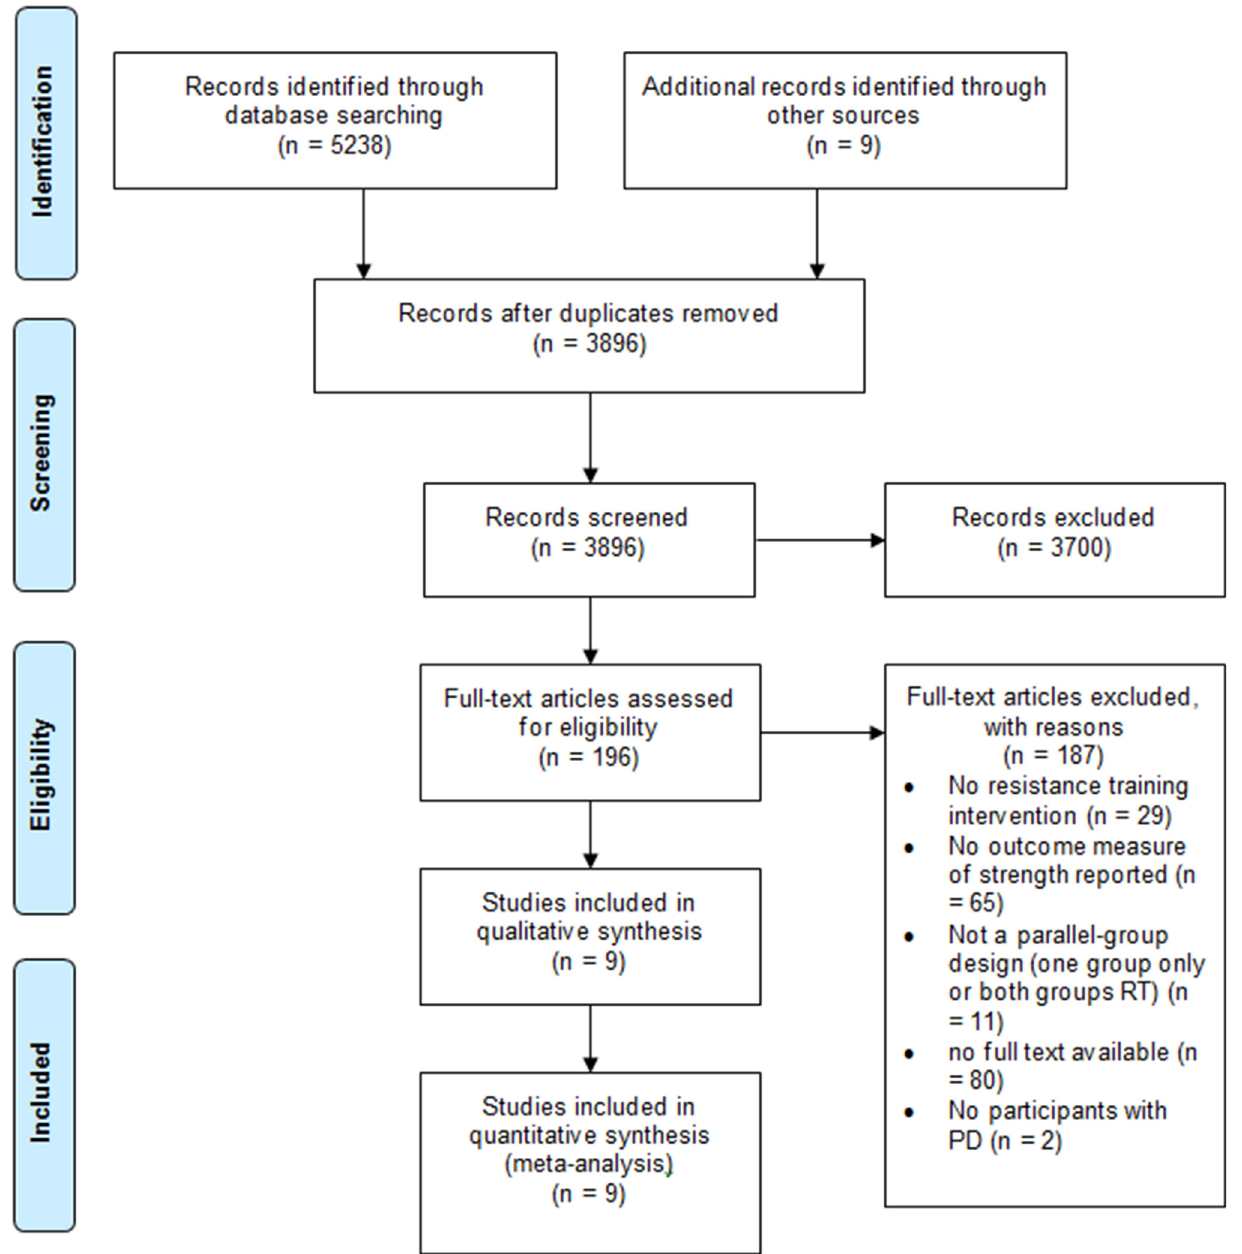
Fig 1. Summary of search and selection process based on included and excluded studies.